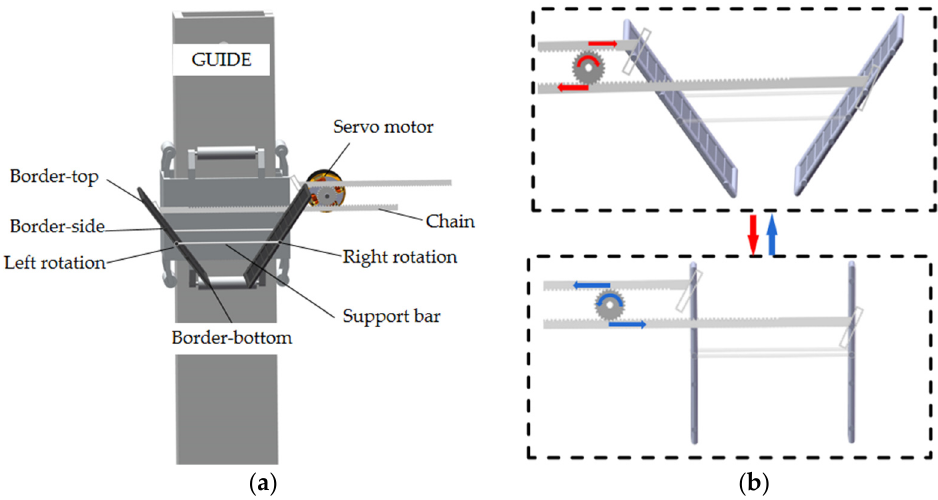
Figure 3. Structure and working principle of the net bag mechanism. ( a ) Structure of net bag ( b ) Working principle of net bag.